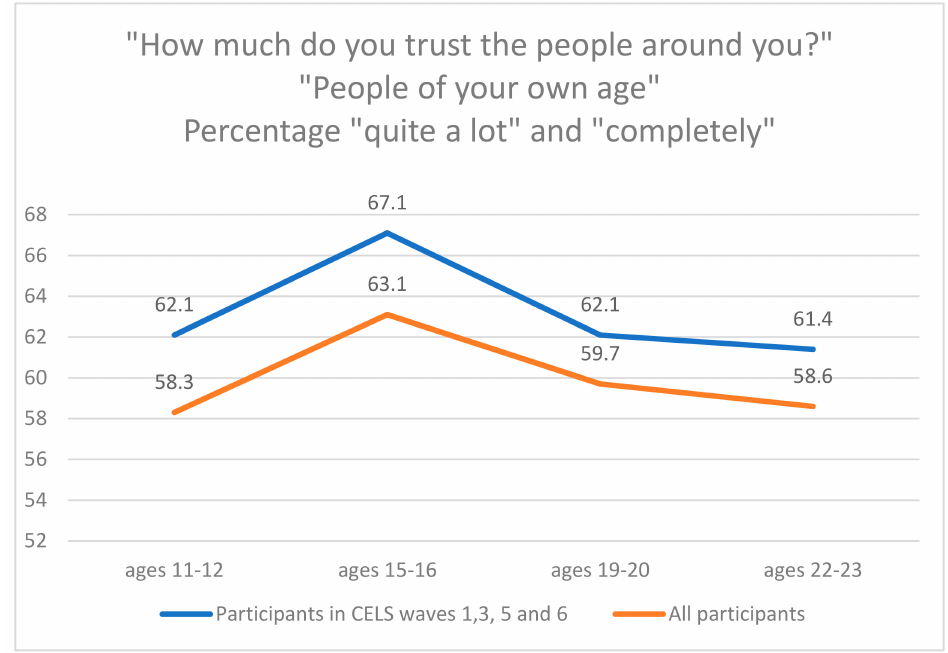
Figure 1. The development of trust in adolescence and early